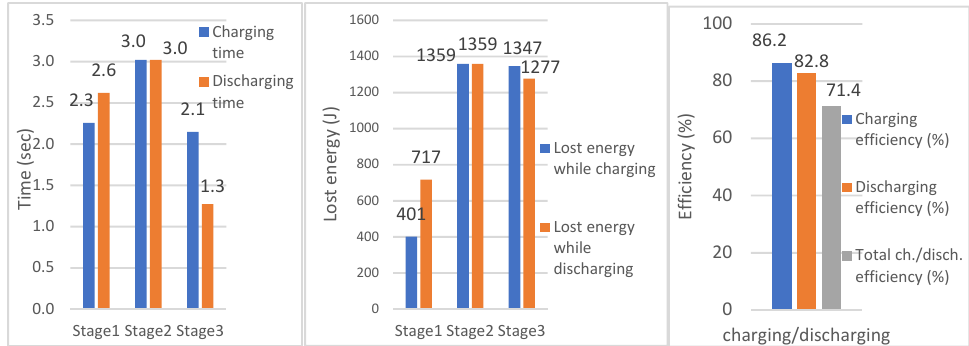
Figure 10. Time and lost energy during charging and discharging at different charging/discharging stages and total charging/discharging efficiencies in the case of five phases with ∆ V x = 1 V.